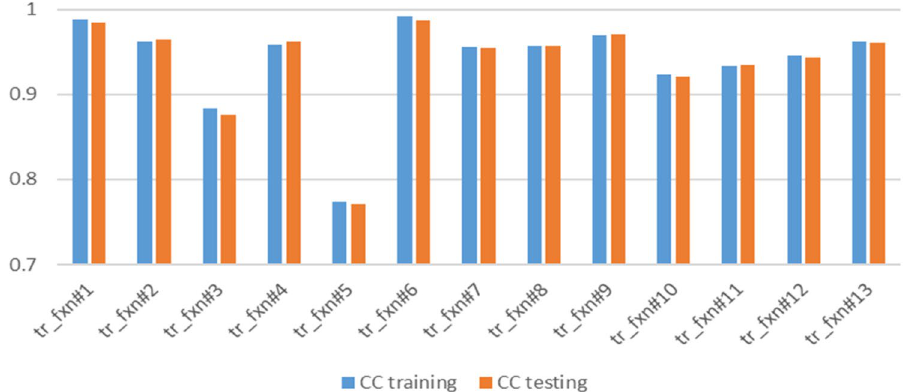
Figure 7. Sensitivity analysis on different training functions.